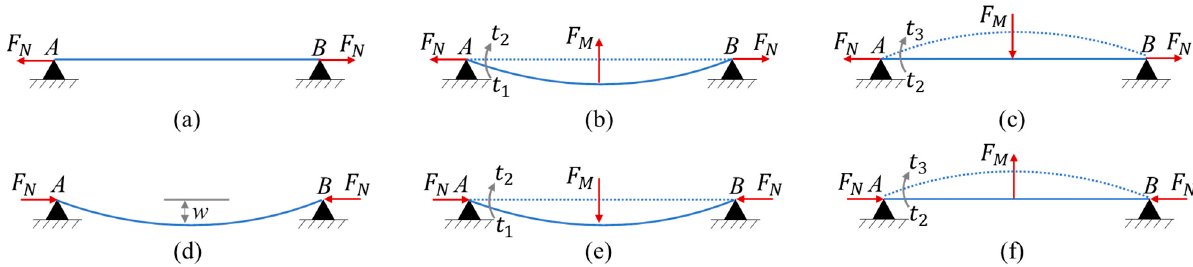
Figure 2. Quasi-steady force analysis of the self-excited resonator with pre-compression and pre-tension constraints for the shift of stable position. ( a – c ) Vibration process of the beam under pre-tension; ( d – f ) Vibration process of the beam under pre-compression. ( a , d ) are the stable position; ( b , e ) are the dynamic process from t 1 to t 2 ; ( c , f ) are the dynamic process from t 2 to t 3 . The solid lines mean the position at current moment, and the dotted lines represent the position in the next.